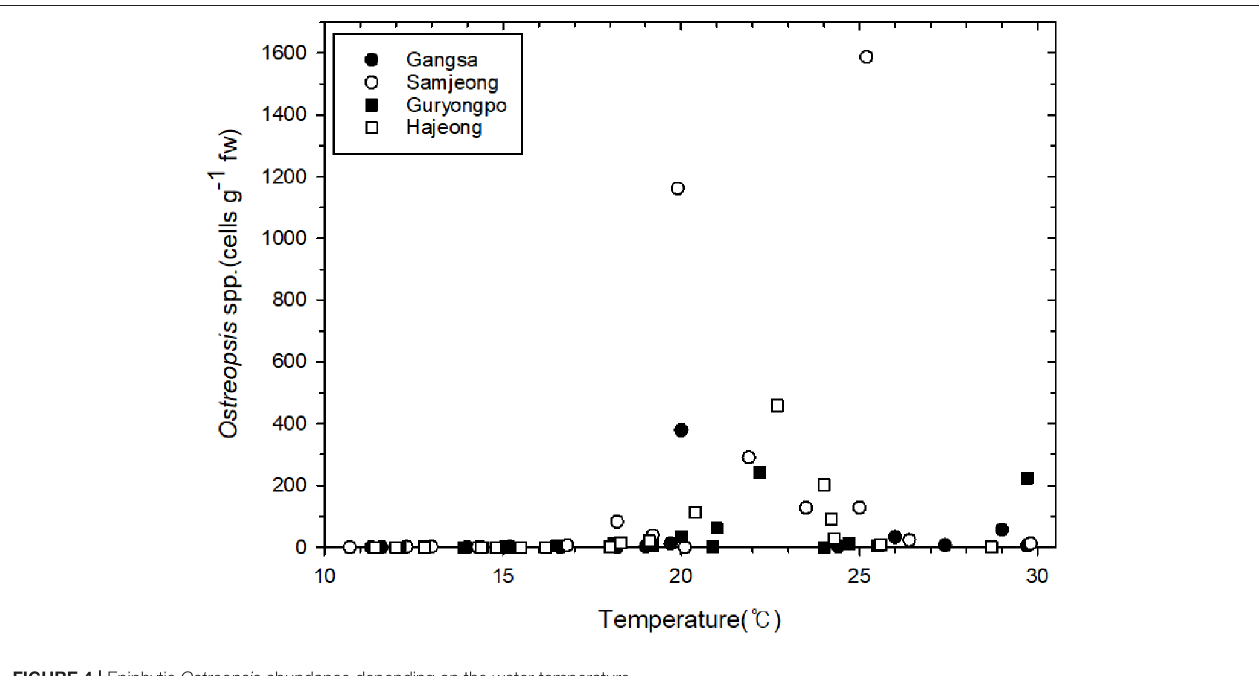
FIGURE 4 | Epiphytic Ostreopsis abundance depending on the water temperature.